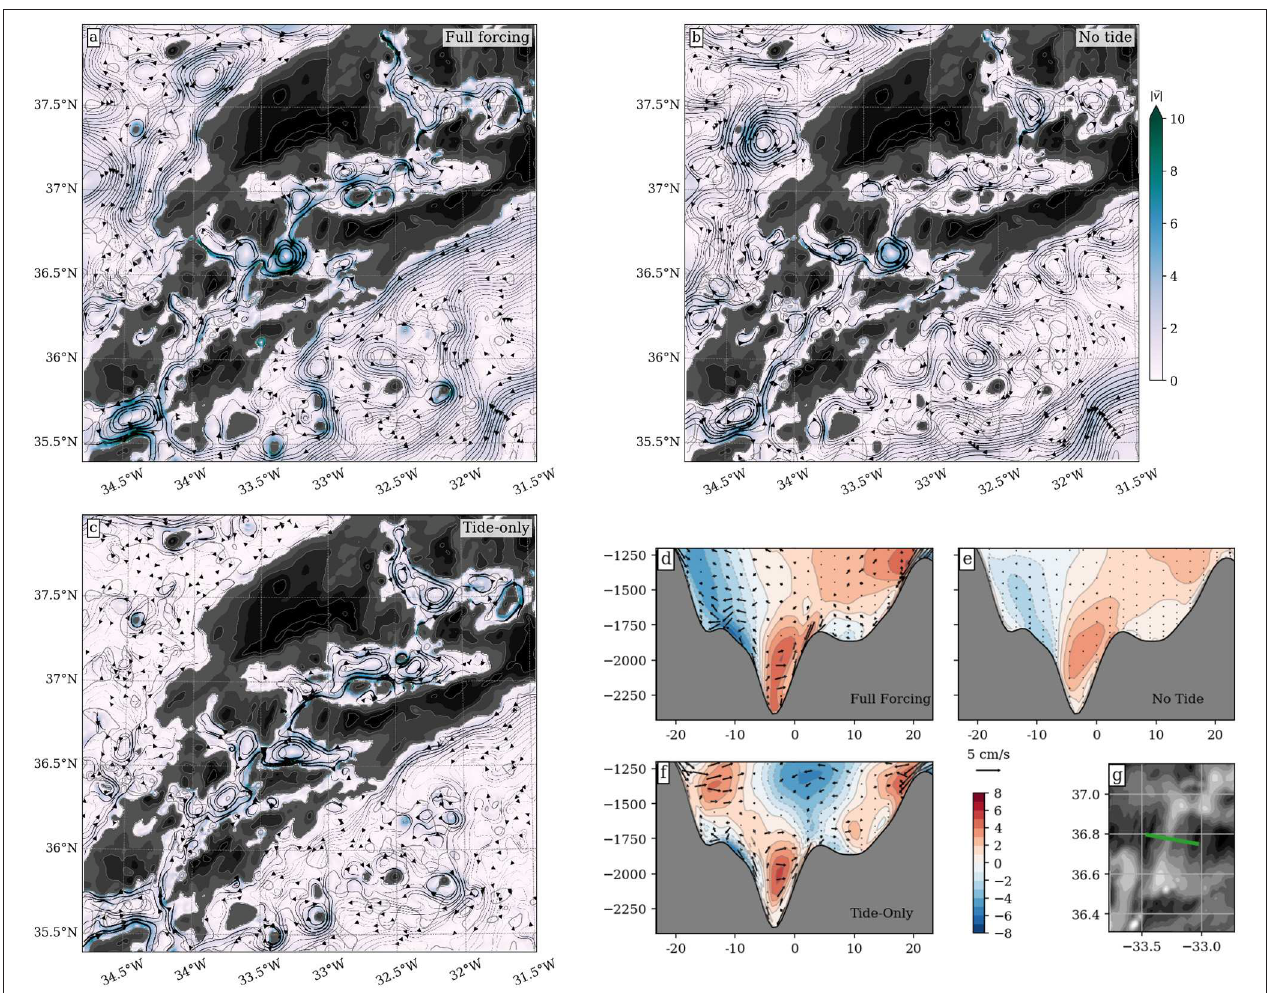
FIGURE 9 | Comparison of different simulations with different forcing, as seen from the mean horizontal current at 2,000 m ( a–c —same convention as in Figure 2 ) and the vertical structure across a section in the Famous segment ( d–f , and localization of the section in g —same convention as in Figure 3 ). The different configurations correspond to full forcing (a,d) , no tide (b,e) , and tide-only (c,f)